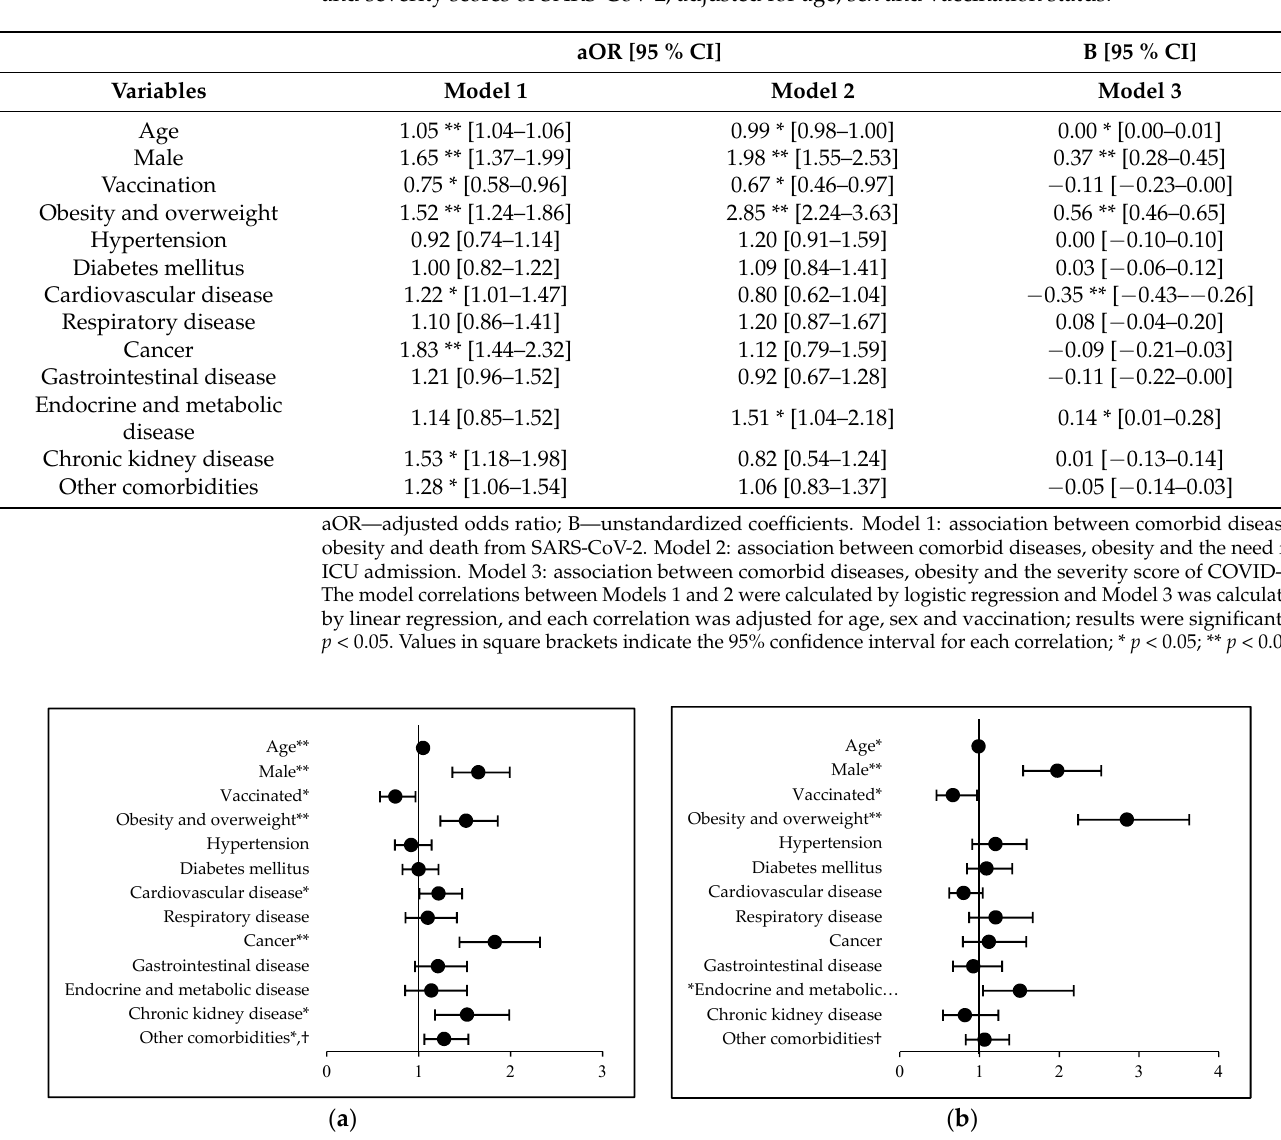
Table 1. Associations between comorbid diseases, obesity, fatal outcome, the need for ICU admission and severity scores of SARS-CoV-2, adjusted for age, sex and vaccination status.